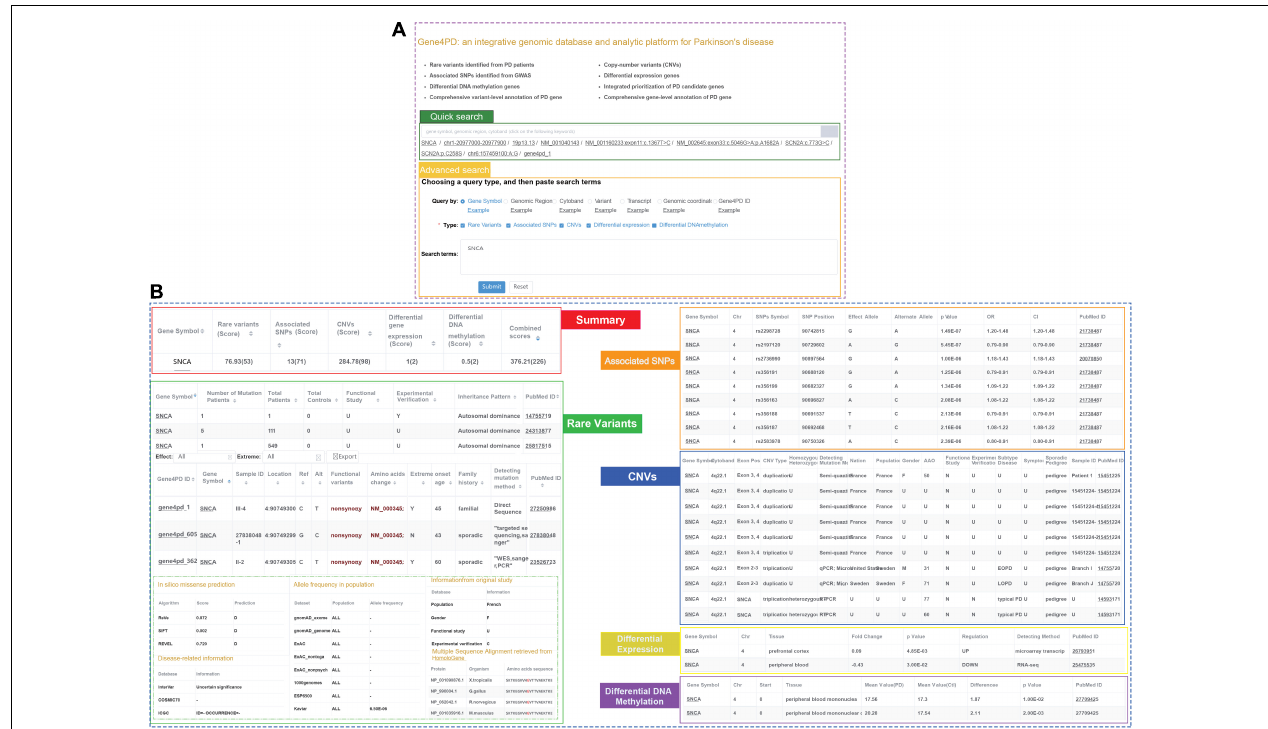
FIGURE 4 | Snapshot of search panel and variant-level implications in Gene4PD. (A) Snapshot of search panel in Gene4PD. Quick search panel and advanced search panel in Gene4PD are illustrated. (B) Snapshot of variant-level implications in Gene4PD. Six sections including “Summary,” “Rare variant,” “Associated SNPs,” “CNVs,” “Differential expression gene,” “Differential DNA methylation,” are set in variant-level